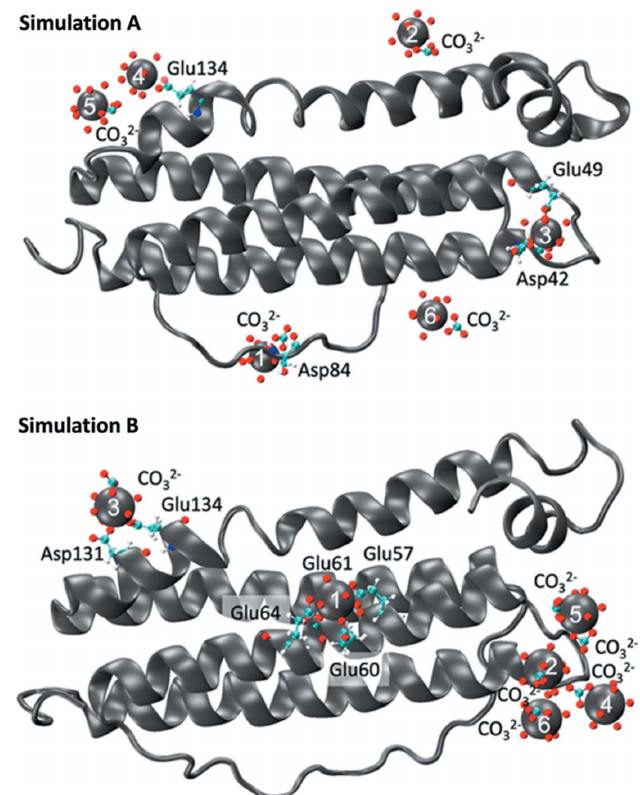
Figure 1 MD simulations of the F–Pu complex. Dark ribbon and dark balls depict protein and Pu atoms, respectively. Protein residues, carbonates and waters associated with Pu atoms are shown in ball-and-stick form. The hydrogen atoms of water have been omitted for clarity. The number of each Pu site refers to Figs. 2( a ) and 2( b ) and Table